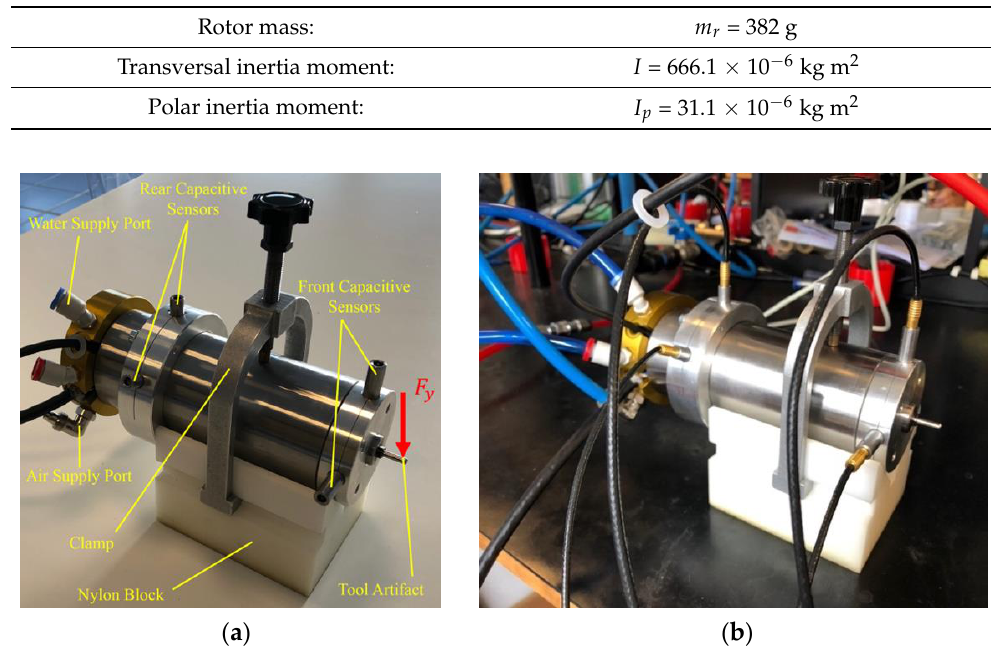
Figure 1. ( a ) Photo of the electro-spindle in horizontal attitude; ( b ) photo of the test setup.